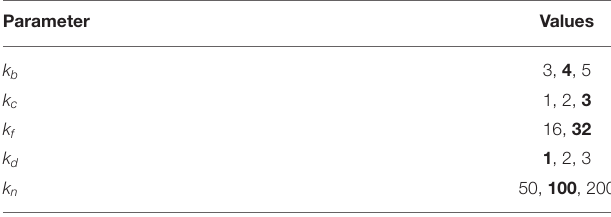
TABLE 2 | Combinations of hyperparameters of the regression networks assessed during hyperparameter analysis. Parameter